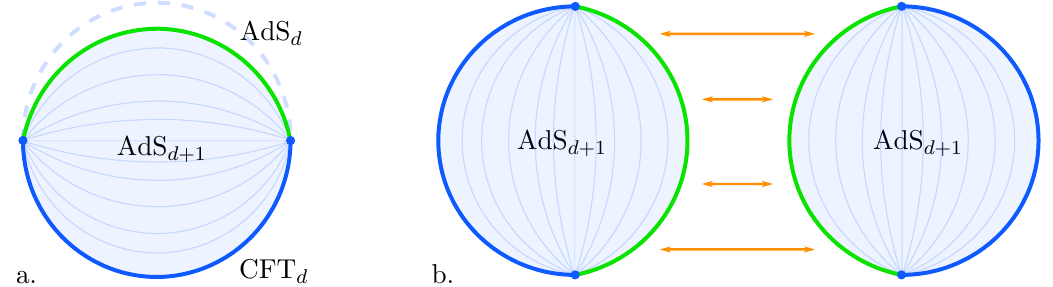
Figure 2 . Panel (a): our Randall-Sundrum construction involves foliating with AdS d slices. Then identical portions of two such AdS d +1 geometries are glued together along an common AdS d slice. Panel (b): the jump in the extrinsic curvature across the interface between the two geometries is supported by a(n in(cid:12)nitely) thin brane. The brane is represented by a green line in the (cid:12)gures and the bulk AdS d +1 spacetime is blue with a d -dimensional CFT at the asymptotic